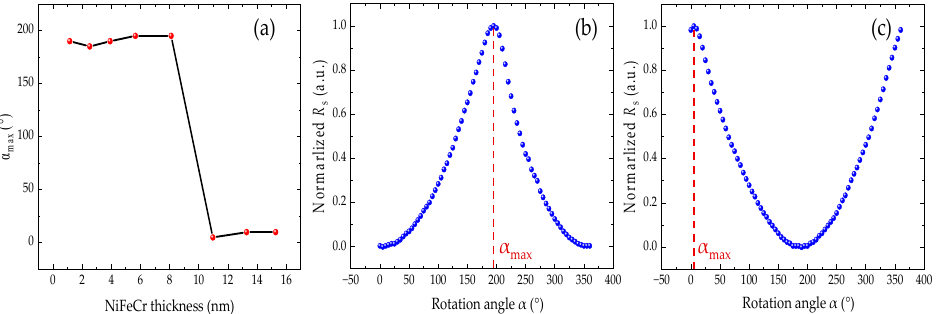
Figure 3. ( a ) Pinning direction variation as a function of the NiFeCr thickness; ( b , c ) angular- dependent sheet resistances at different NiFeCr thicknesses: ( b ) t = 8.2 nm and ( c ) t = 15.3 nm.